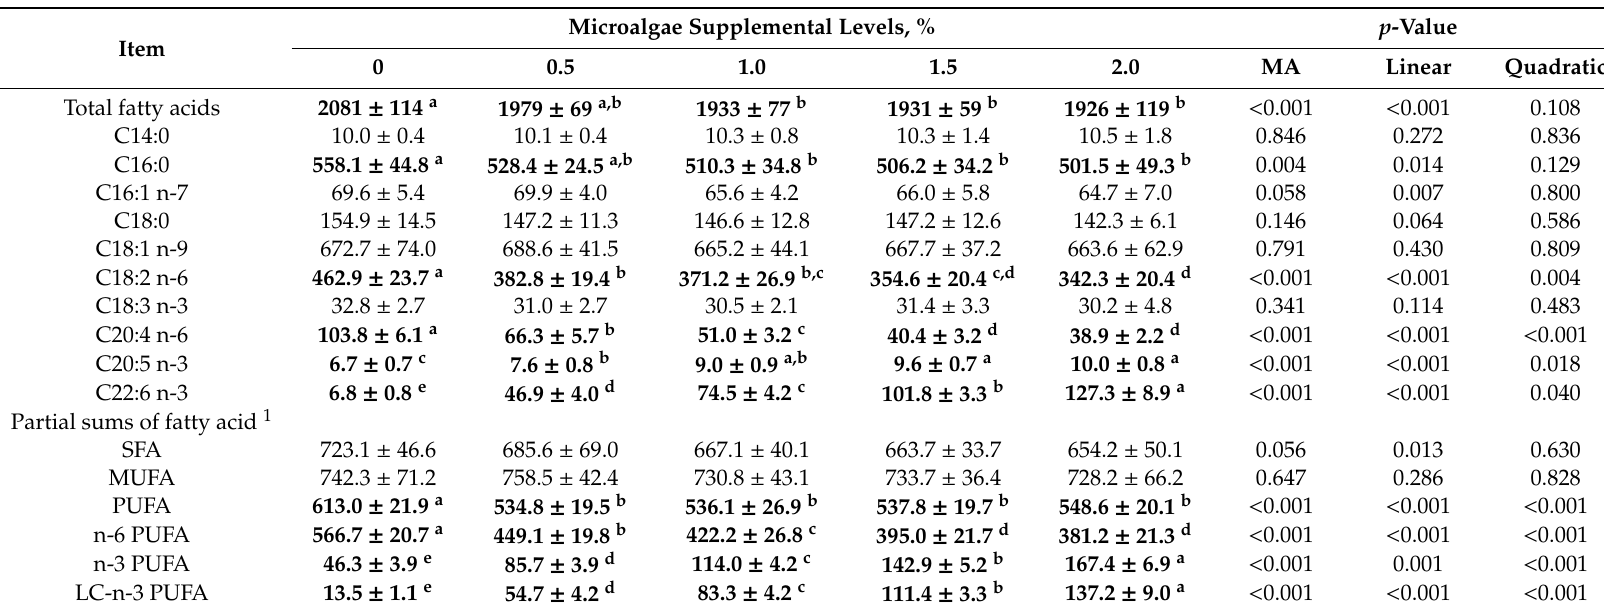
Values are means ± standard deviations ( n = 12). Bold-faced means in the same row with di ff erent letters di ff er significantly ( p < 0.05). 1 SFA (sum of saturated fatty acids) = C14:0 + C16:0 + C18:0; MUFA (sum of monounsaturated fatty acids) = C16:1 n-7 + 18:1 n-9; PUFA (sum of polyunsaturated fatty acids) = C18:2 n-6 + C18:3 n-3 + C20:4 n-6 + C20:5 n-3 + C22:6 n-3;